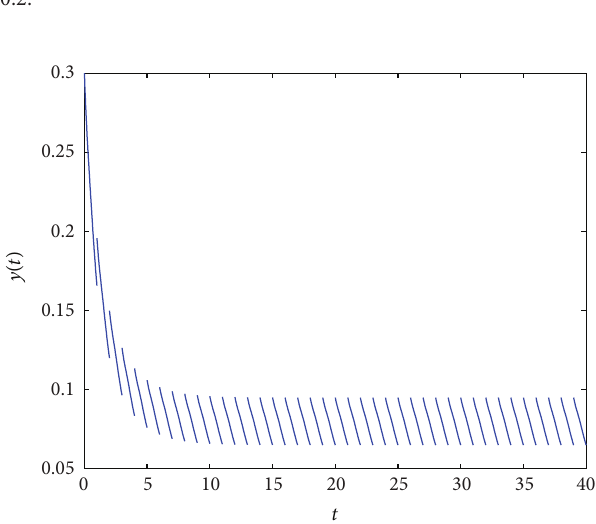
Figure 3: Permanence of system (7a) and (7b) with 𝑦(0) = 0.3 , 𝑎(𝑡) = −0.2 + 0.1 sin 2𝜋𝑡 , 𝑏(𝑡) = 1.5 + 0.1 cos 2𝜋𝑡 , 𝑐(𝑡) = 0.11 + 0.1 sin 2𝜋𝑡 , 𝑑(𝑡) = 1.5 + sin 2𝜋𝑡 , and 𝑝 = 0.03 . Time series of species 𝑦 for 𝑡 ∈ [0,40]